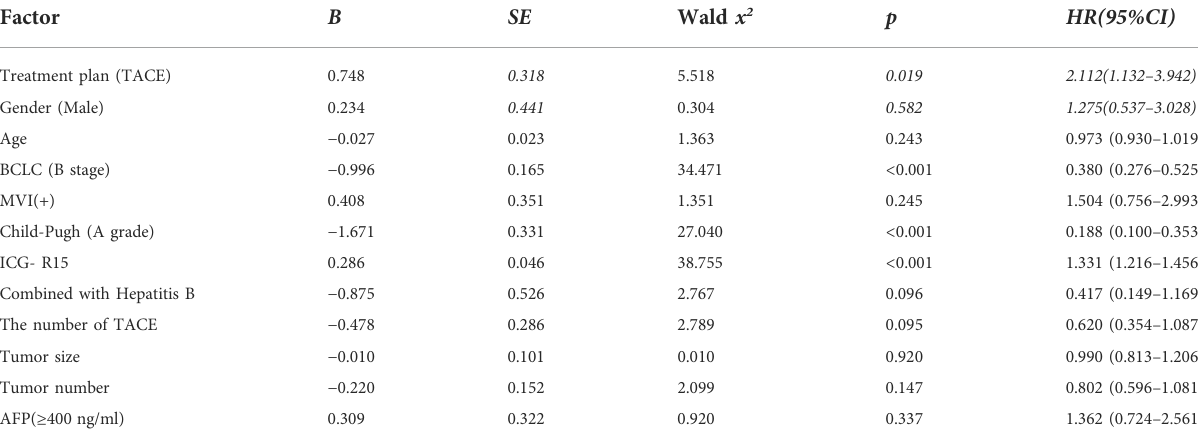
TABLE 6 Unvariate COX regression analysis affecting prognosis. Factor